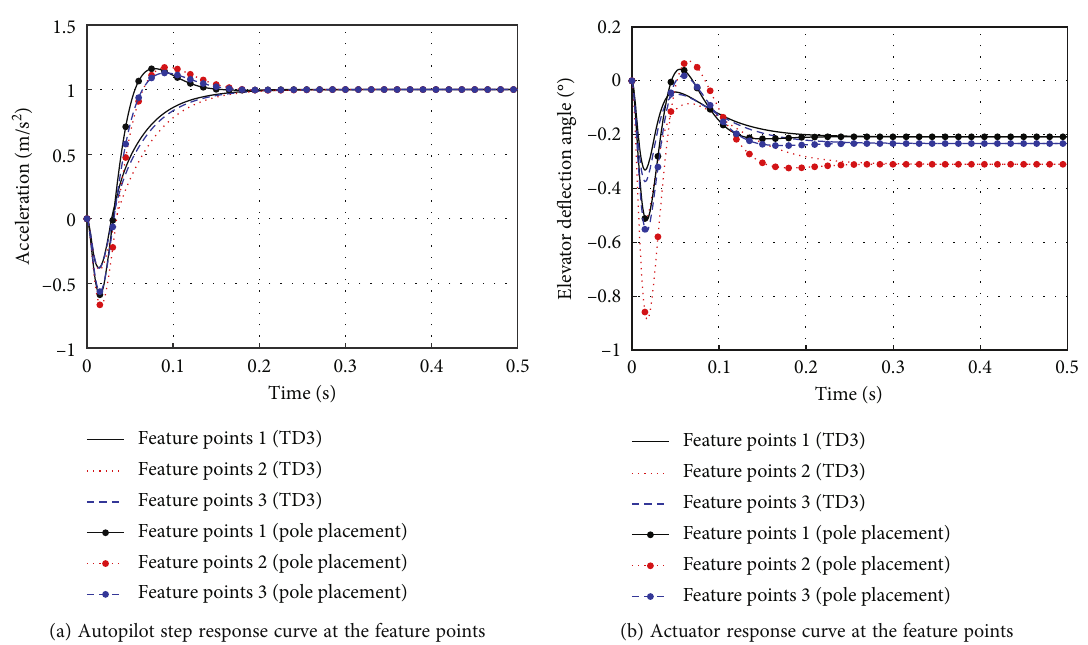
Algorithm. First, the design state space of the autopilot